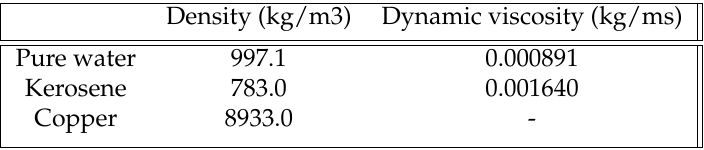
Table 1. Table 1. Physical properties of copper nanoparticles, water and